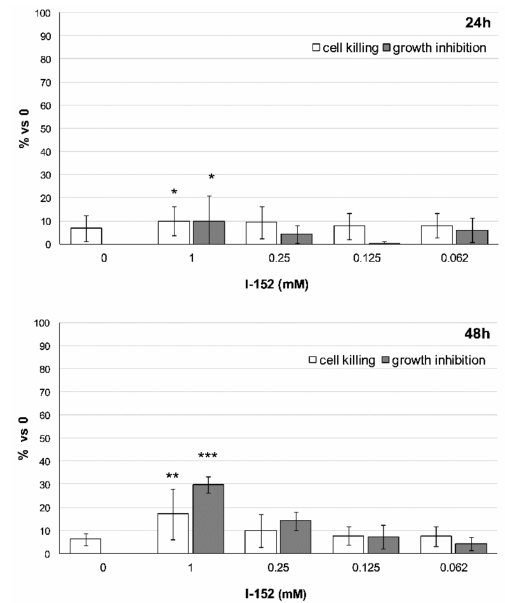
Figure 10. Cell killing and growth inhibition after I-152 treatment. Cells were incubated with different doses of I-152 for 24 h and 48 h. Untreated cells receiving only fresh medium served as a control (denoted by 0). LDH activity was measured for each condition in the cell culture medium and, in parallel, in the medium after complete cell lysis with Triton-X100. This method makes it possible to distinguish cell death versus growth inhibition as described in materials and methods. Data are reported in the graph as fold change relative to control (0). The values are the mean ± SD of two independent experiments with four technical replicates. * p < 0.05, ** p < 0.01, *** p <